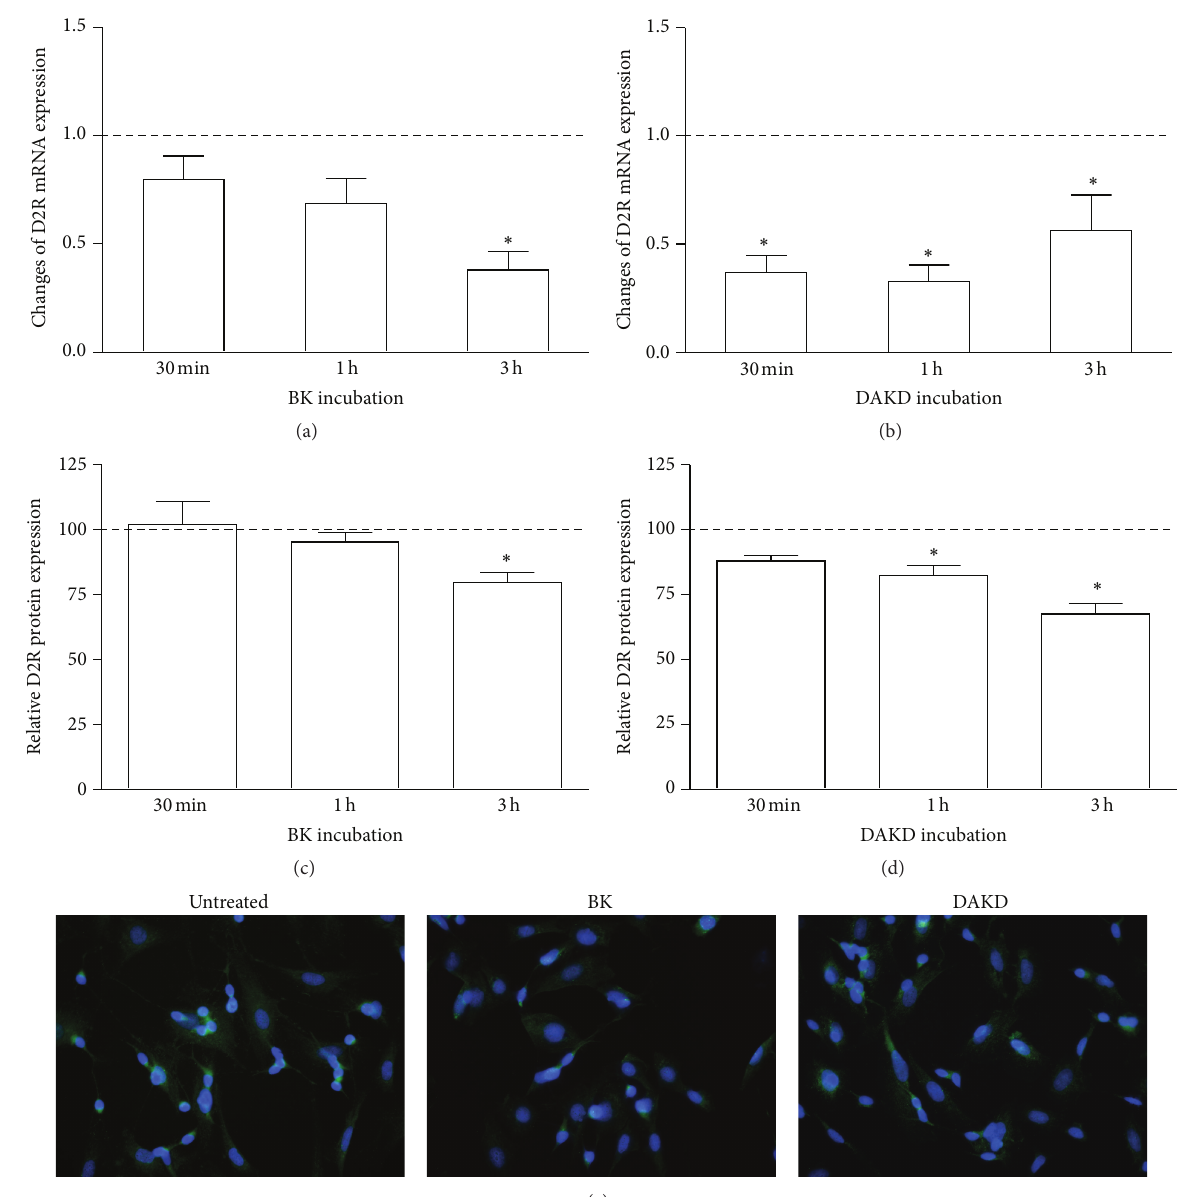
Figure 8: The effect of kinin peptides on D2R expression in differentiated SK-N-SH cells. The mRNA expression of D2R was analyzed with Real-Time PCR after BK (a) or DAKD (b) treatment of confluent cells at different time intervals. D2R mRNA expression is shown as relative mean values as compared to untreated cells, assumed to possess value equal to 1 (dashed line). The expression of D2R protein was analyzed by immunocytochemistry with specific antibodies and the quantification of fluorescence signal was performed as described in Materials and Methods (c, d). The results are shown as mean ± SD of the changes in comparison to untreated cells, assumed to possess 100% expression (dashed line). The photographs show D2R expression on differentiated SK-N-SH cells without or after 3-hour incubation with BK or DAKD (e). ∗ 𝑃 < 0.05 versus untreated